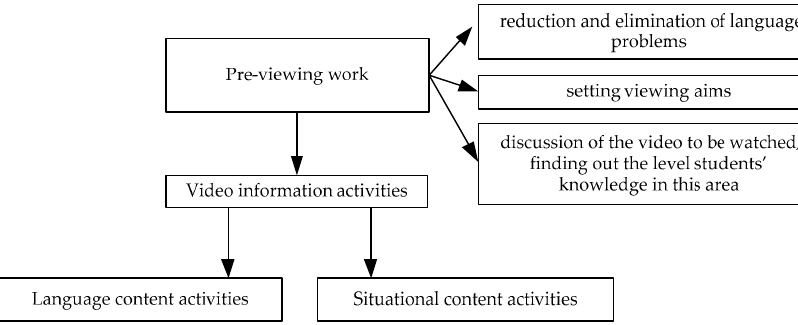
Figure 4. The main stages of educational process based on audiovisual technologies .